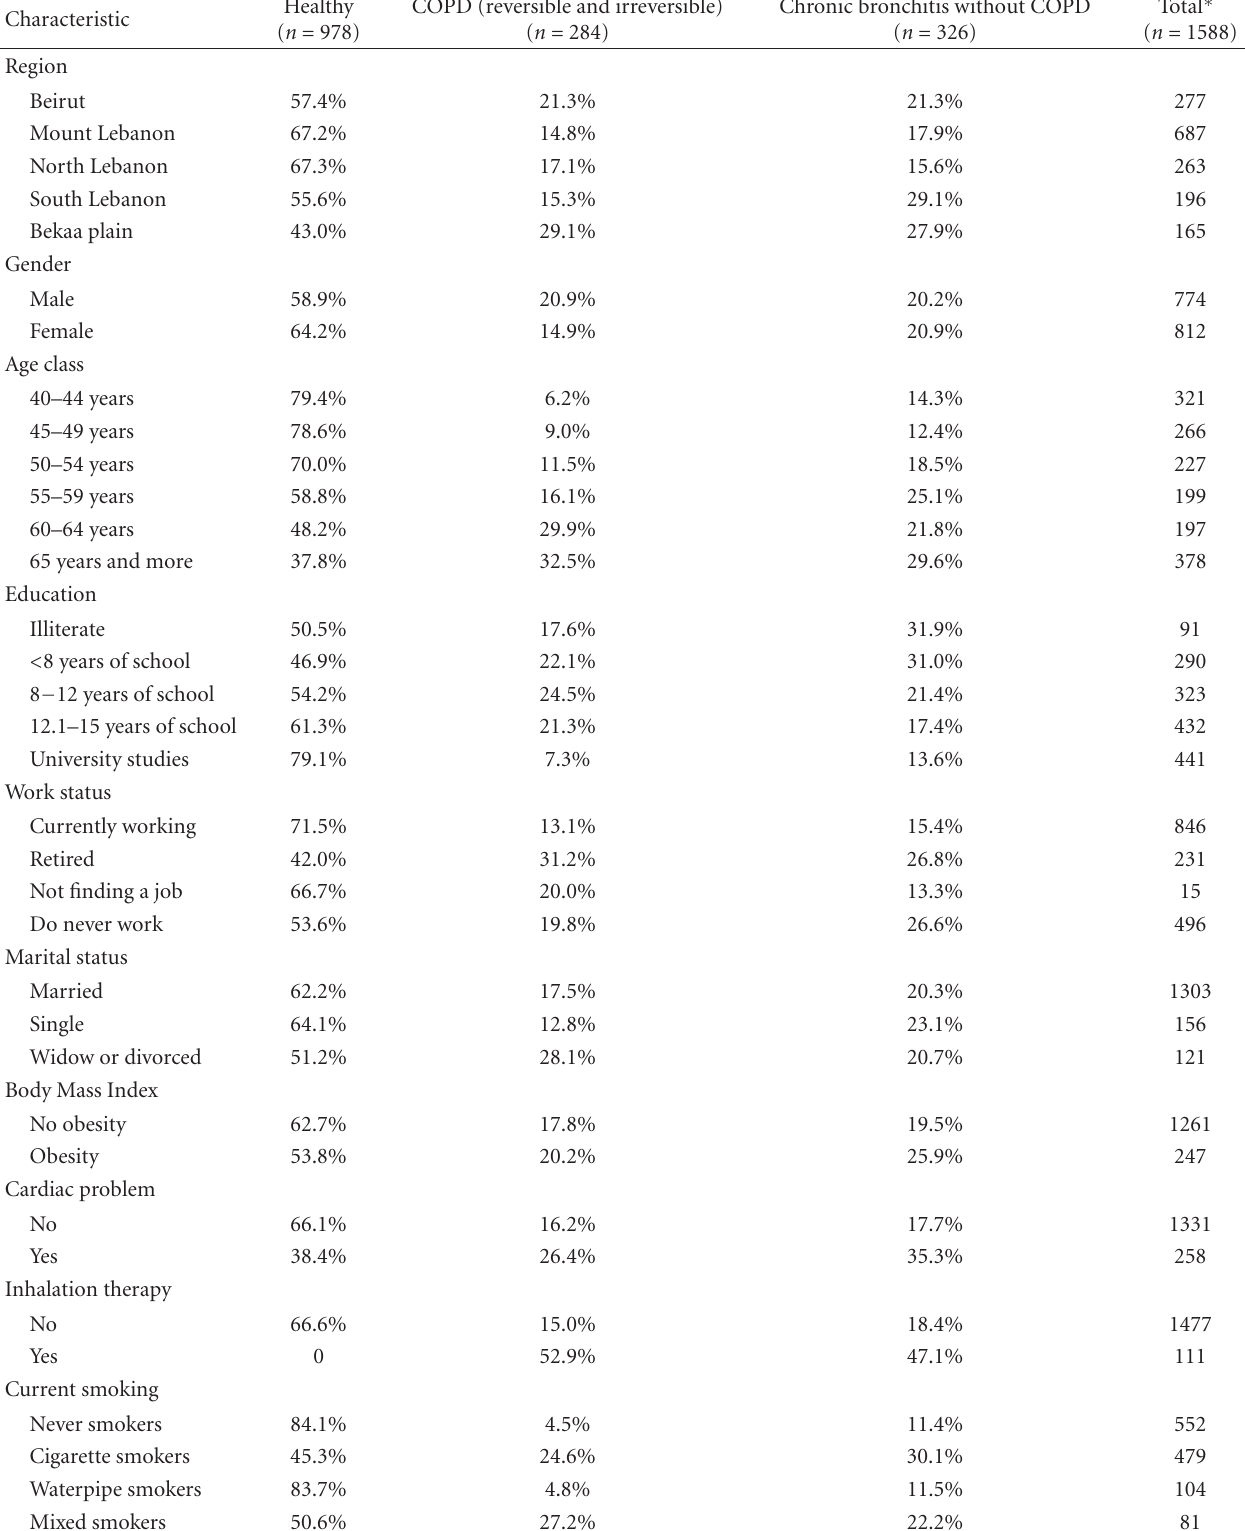
Table 1: Sociodemographic characteristics of the study